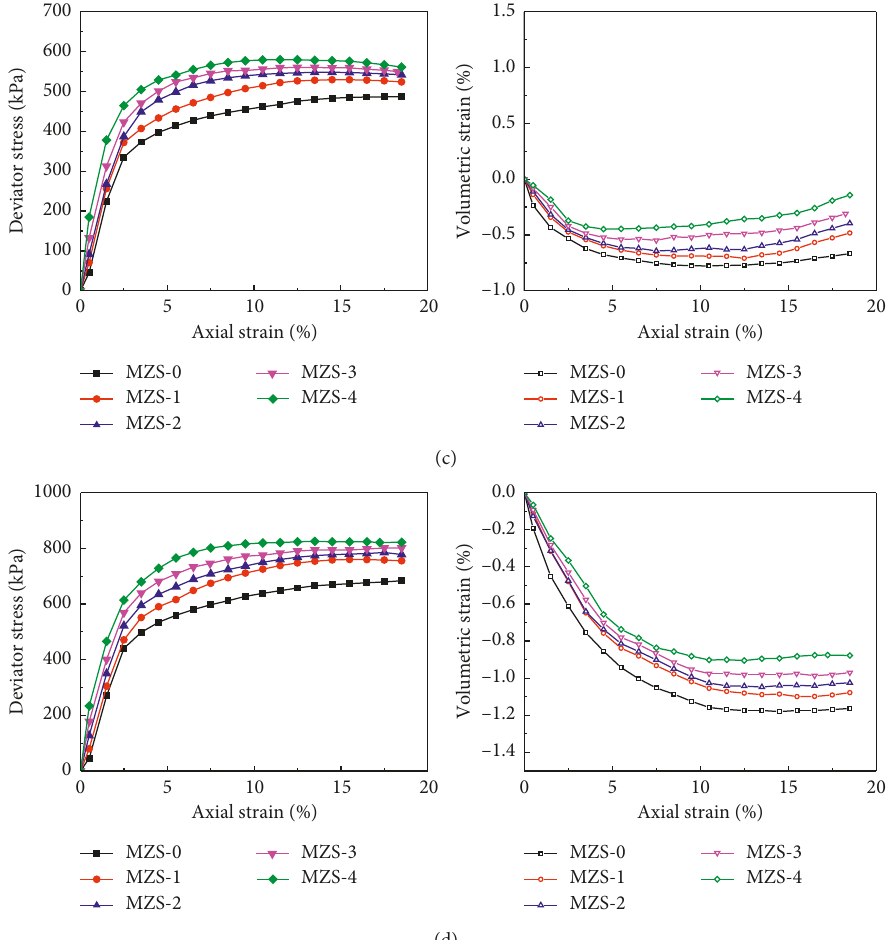
Figure 8: Drained shear (CDC) behavior of treated loess with different contents of lignin at different effective confining pressures. (a) 80kPa. (b) 140kPa. (c) 200kPa. (d)